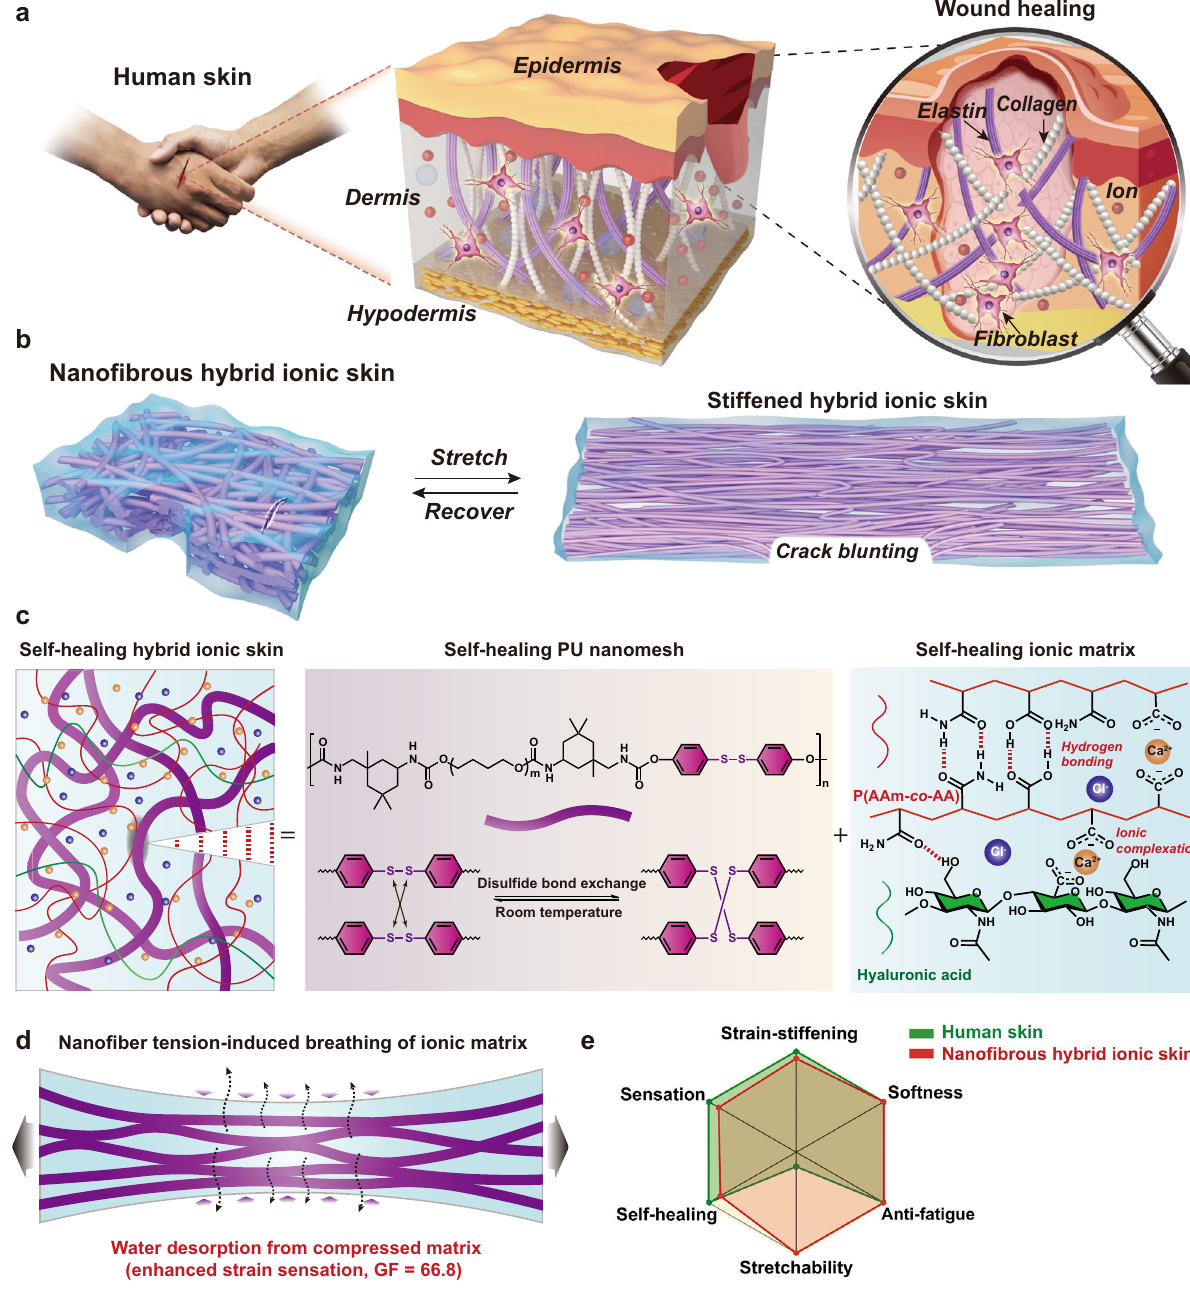
Water desorption from compressed matrix (enhanced strain sensation, GF = 66.8) Fig. 1 | Design of fatigue-free and self-healable nano fi brous hybrid ionic skin. blunting mechanism. c Schematic illustrations of the hybrid structure and a Schematic ion-rich, nano fi brous composite structure and wound-repairing respective self-healing mechanisms of PU nanomesh scaffold and ionic matrix. d Nano fi ber tension forces the hygroscopic ionic matrix to reversibly breathe mechanism ofhumanskin. Both the collagen fi brils and elastin matrix are healable moisture in air, leading to substantially enhanced strain sensation (gauge factor, with the aid of fi broblasts. b Schematic structural changes of self-healable nano fi - GF=66.8). e A rough comparison of the sensing and mechanical performance broushybridionicskinuponreversiblestretching.Hybridionicskinrapidlystiffens between human skin and nano fi brous hybrid ionic as deformed and is highly anti-fatigue-fracture through a nano fi ber-induced crack